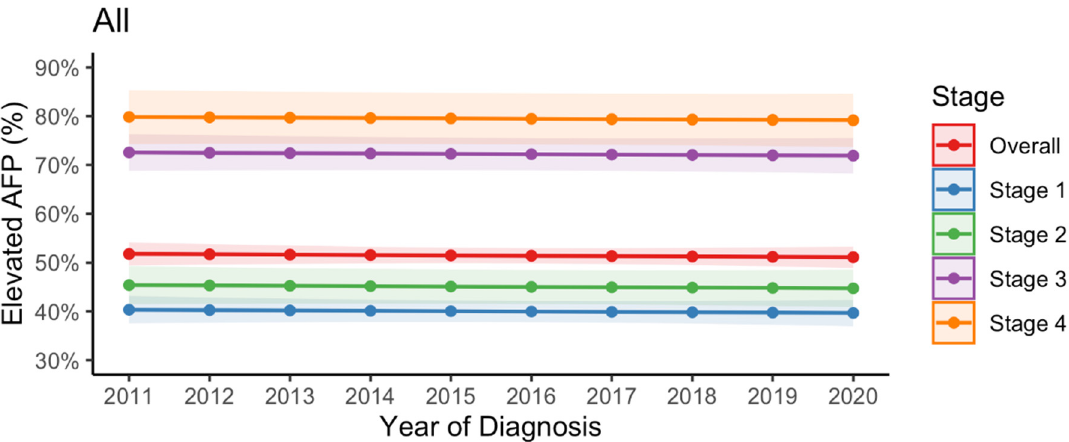
Figure 1. Trend in elevated serum alpha-fetoprotein levels (i.e., ≥ 20 ng/mL) at the time of hepatocellular carcinoma diagnosis in all patients and at different stages (seventh edition American Joint Committee on Cancer).